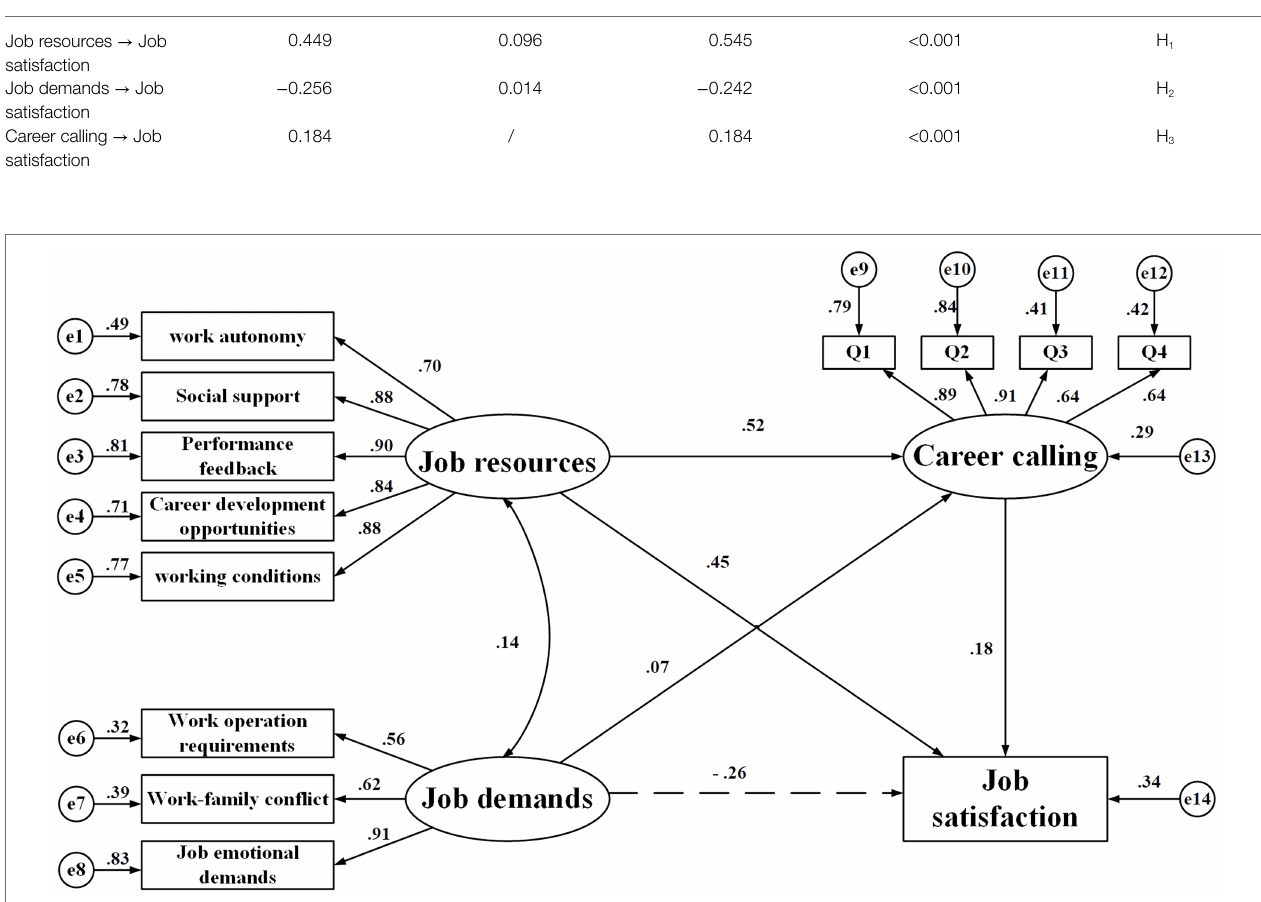
FIGURE 2 | Model for the mechanism of the effects of factors on job